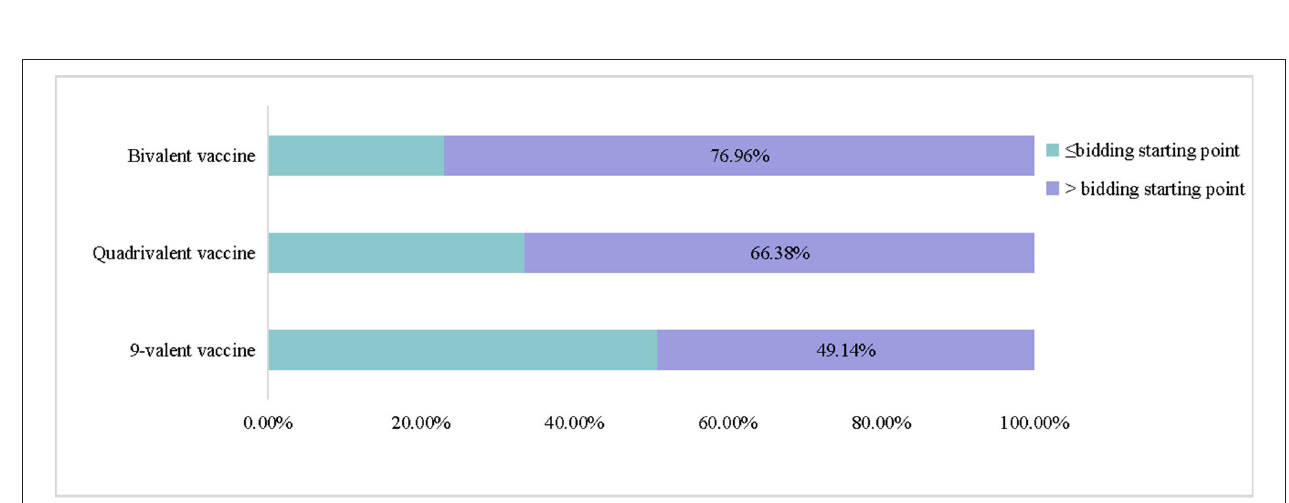
FIGURE 3 | Respondents’ willing to pay for HPV vaccination.